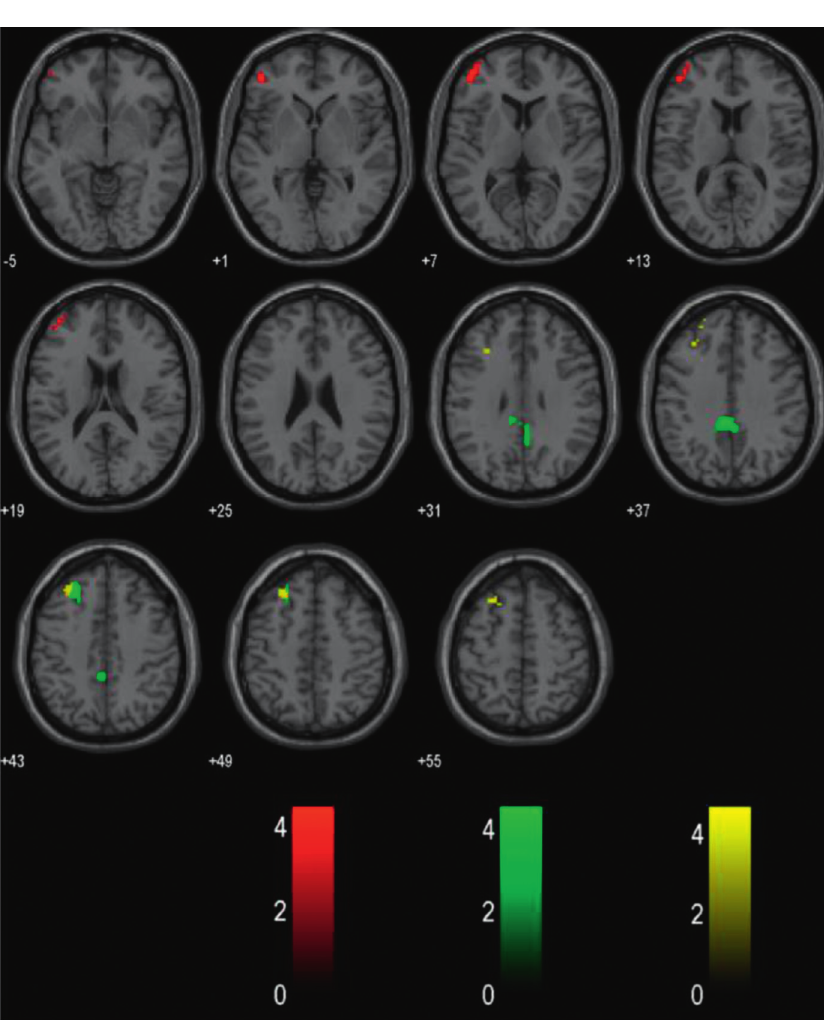
Figure 2: The red color represents the VBM results, the green color represents the rs-FC result of the MwoA-DI group vs. the HC group, and the yellow color represents the rs-FC result of the MwoA-DI group vs. the MwoA-DA group. The rs-FC result found the functional connectivity with the middle frontal cortex (upper) was decreased in MwoA-DI patients compared to HCs and MwoA-DA patients.